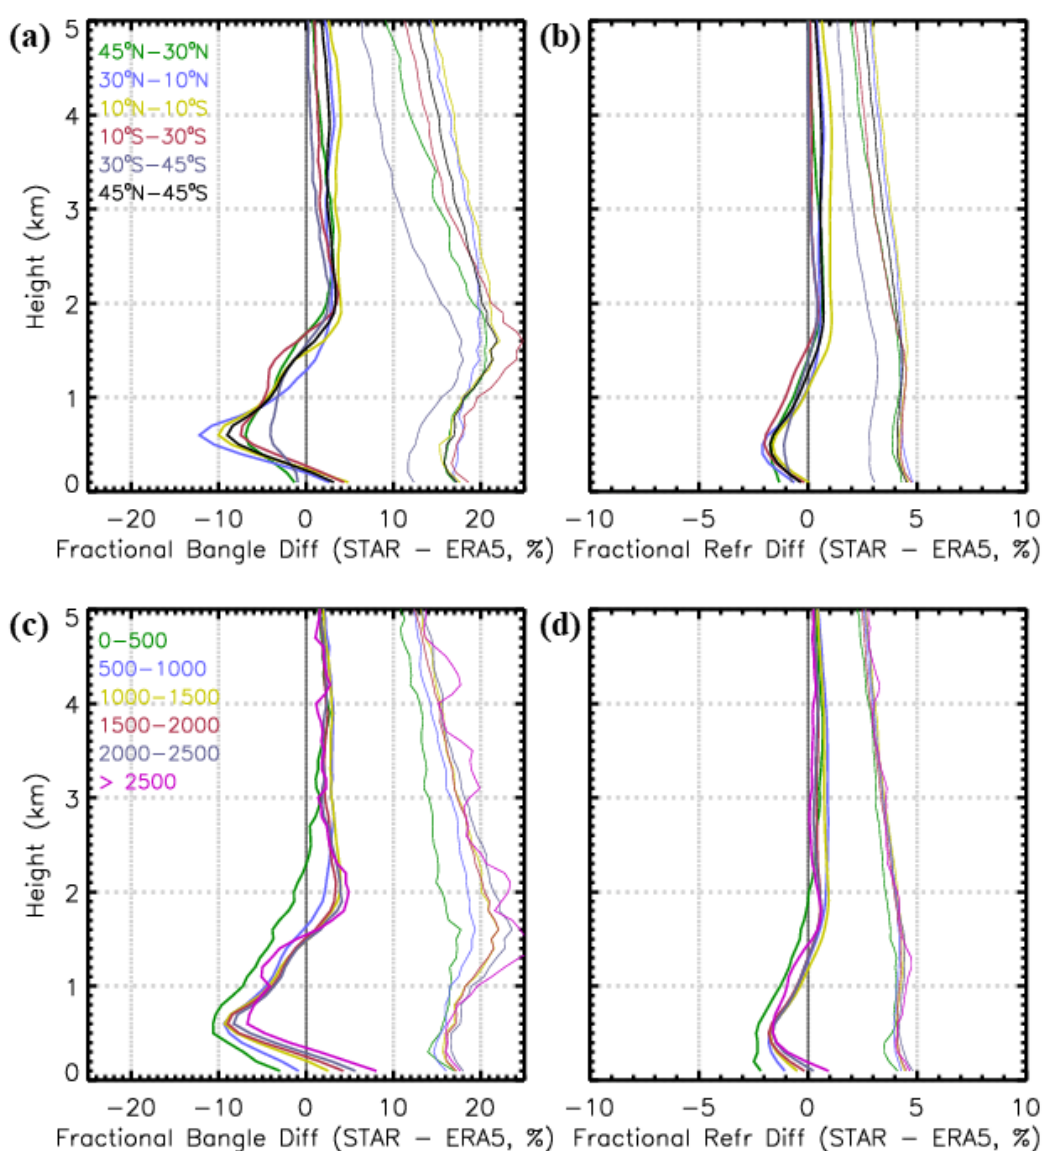
Figure 14. Latitudinal distribution of the STAR-ERA5 ( a ) fractional bending angle, ( b ) fractional refractivity, STAR–ERA5 ( c ) fractional bending angle, and ( d ) fractional refractivity at different SNR values. The thick lines represent the mean values, and the corresponding thin lines represent standard deviation.